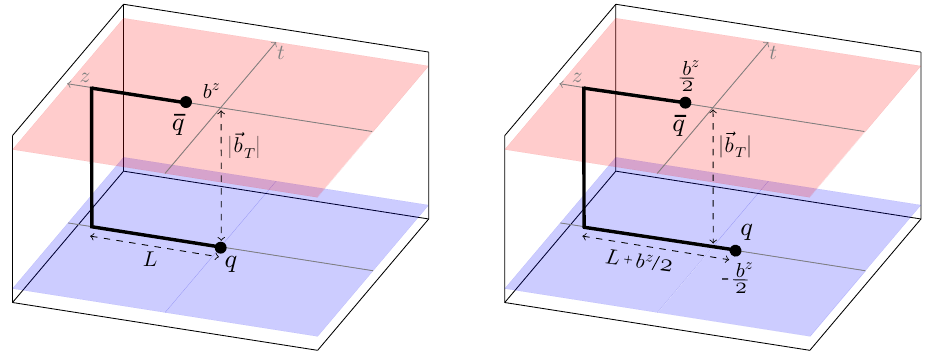
Figure 2. Illustration of the Wilson line structure of the quasi beam function ~ B q as de(cid:12)ned in eq. (2.15) (left) and eq. (2.21)